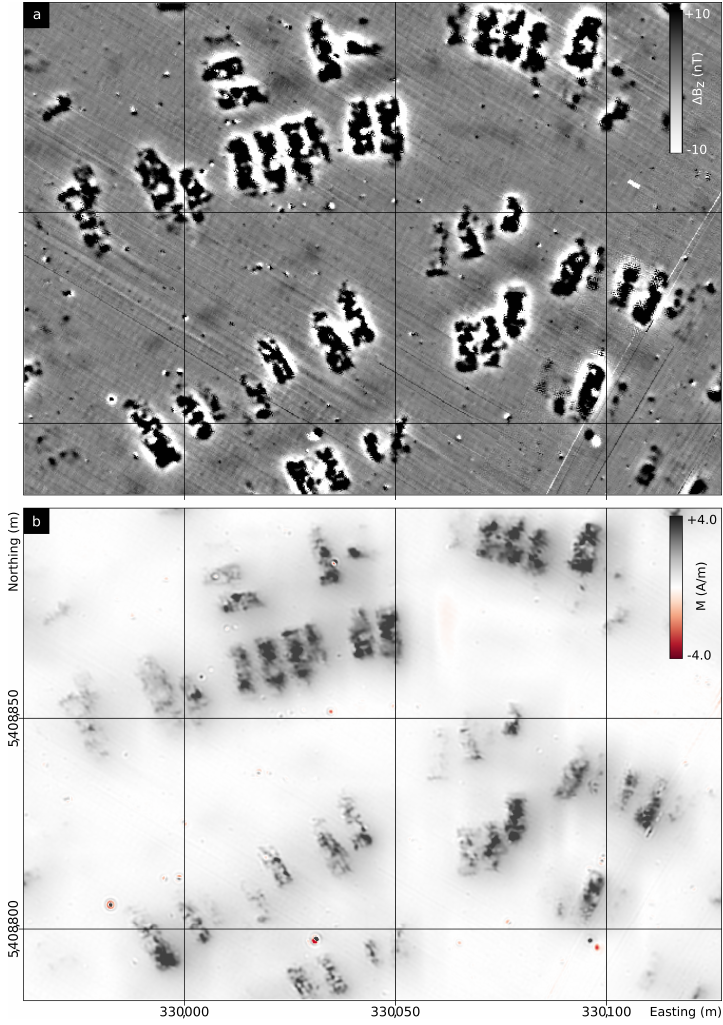
Figure 10. Comparison of the magnetic map ( a ) and the magnetization distribution ( b ) for a subarea of the site with several anomalies of burnt buildings. The location of this subarea is marked in Figure 9 with a blue